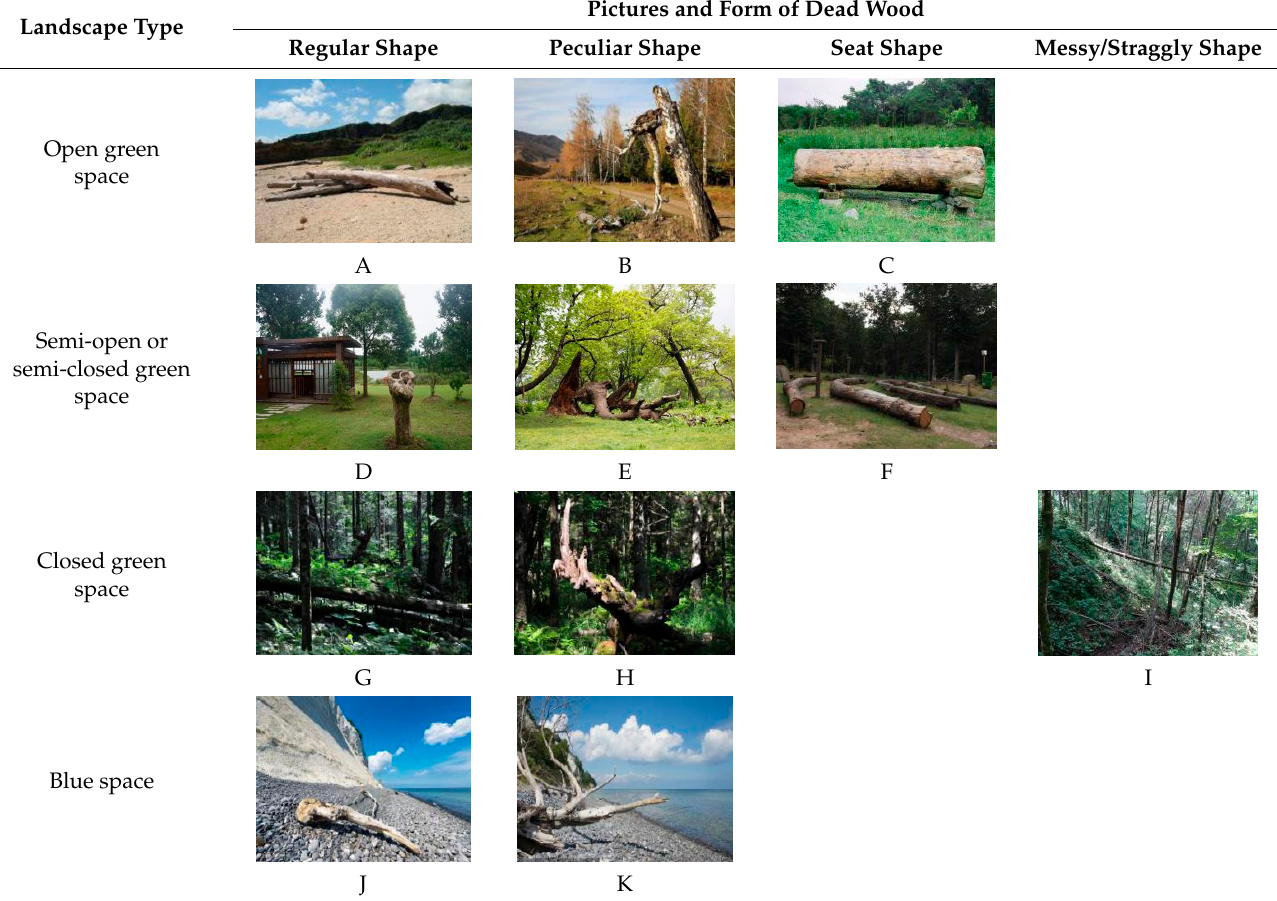
Table 1. Eleven photos with the different forms of dead wood in the four types of environment.